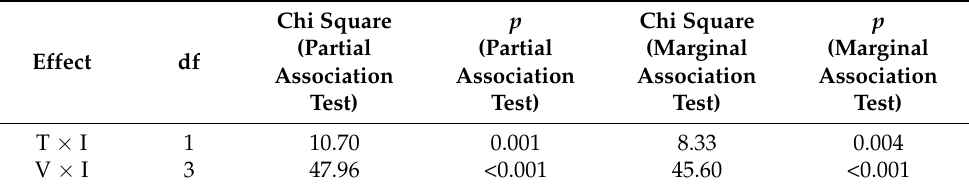
Table 3. Log linear results showing the effect of each factor (T = treatment; V = vineyard) on the percentage of infested bunches (I = infestation).